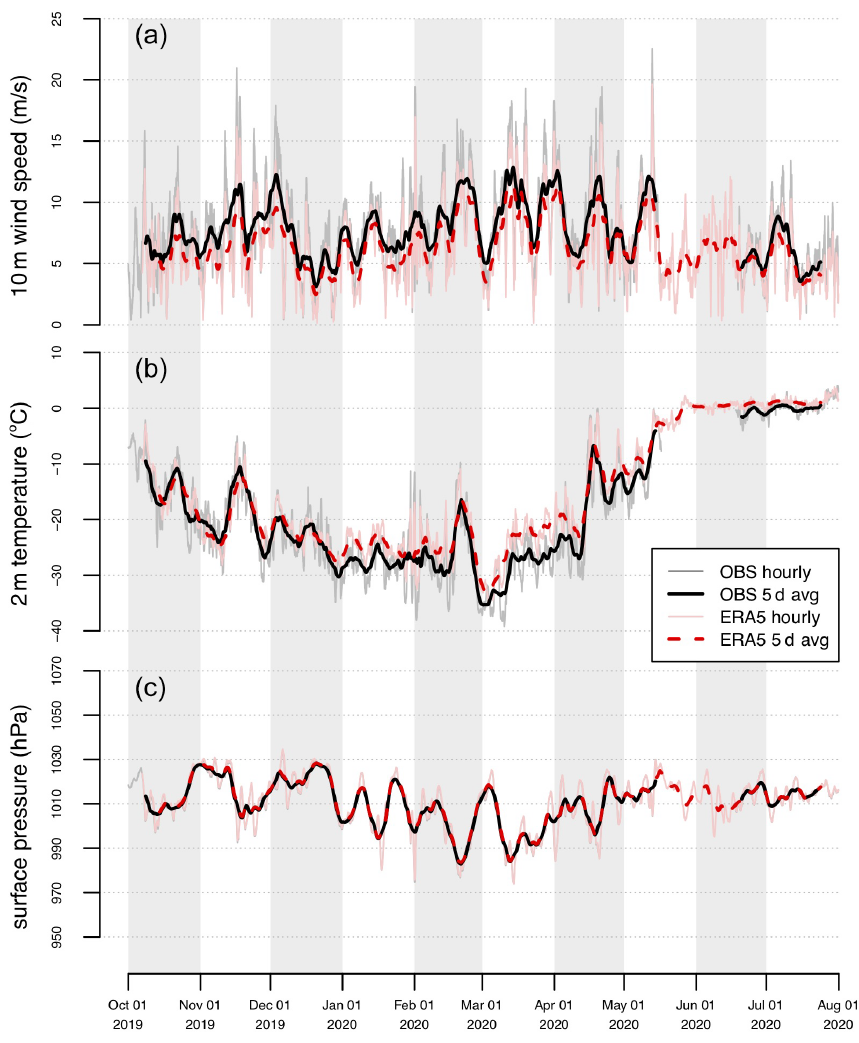
Figure 7. Atmospheric conditions along the MOSAiC drift trajectory in 2019–2020 according to ERA5 (red and light red) and according to ship measurements (black and gray). Hourly data are depicted in light red and gray; the 5d averages are depicted in red (dashed) and black. Panels show the (a) 10m wind speed, (b) 2m air temperature and (c) surface air pressure,